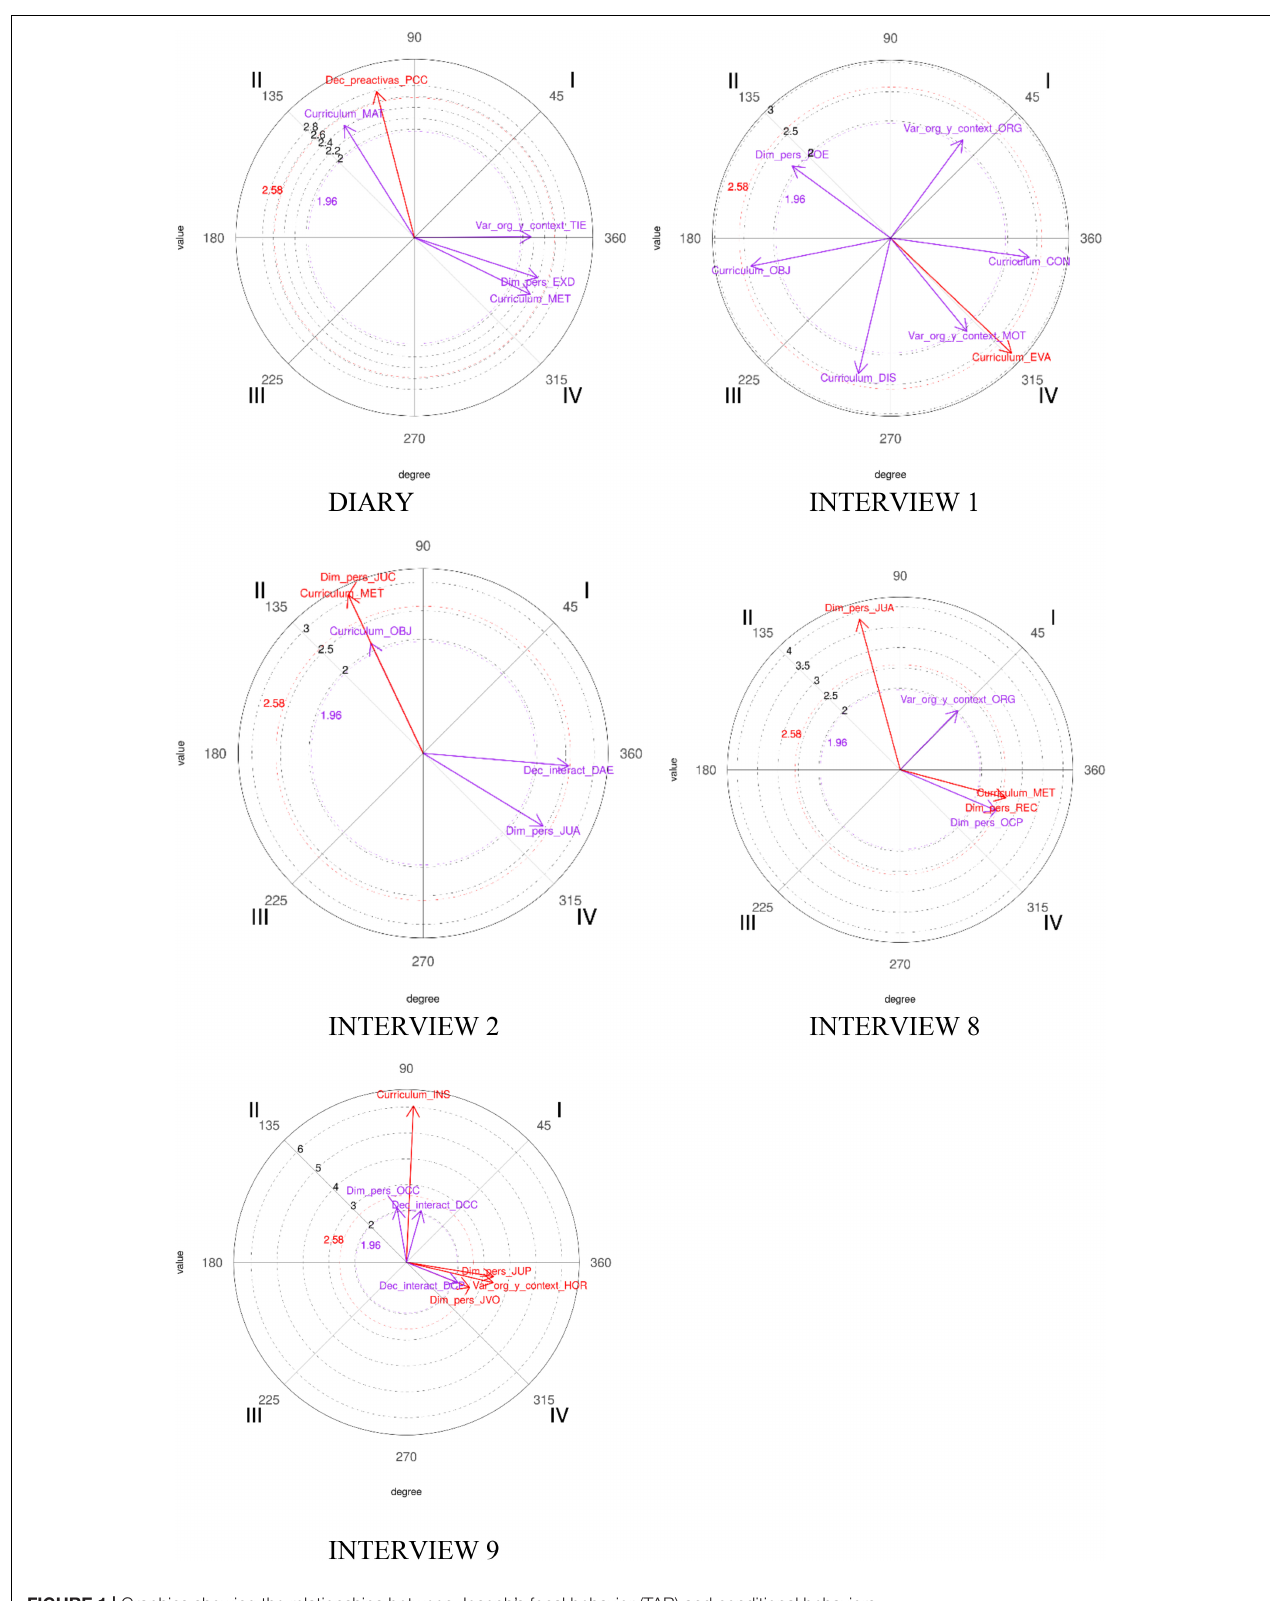
Frontiers in Psychology |